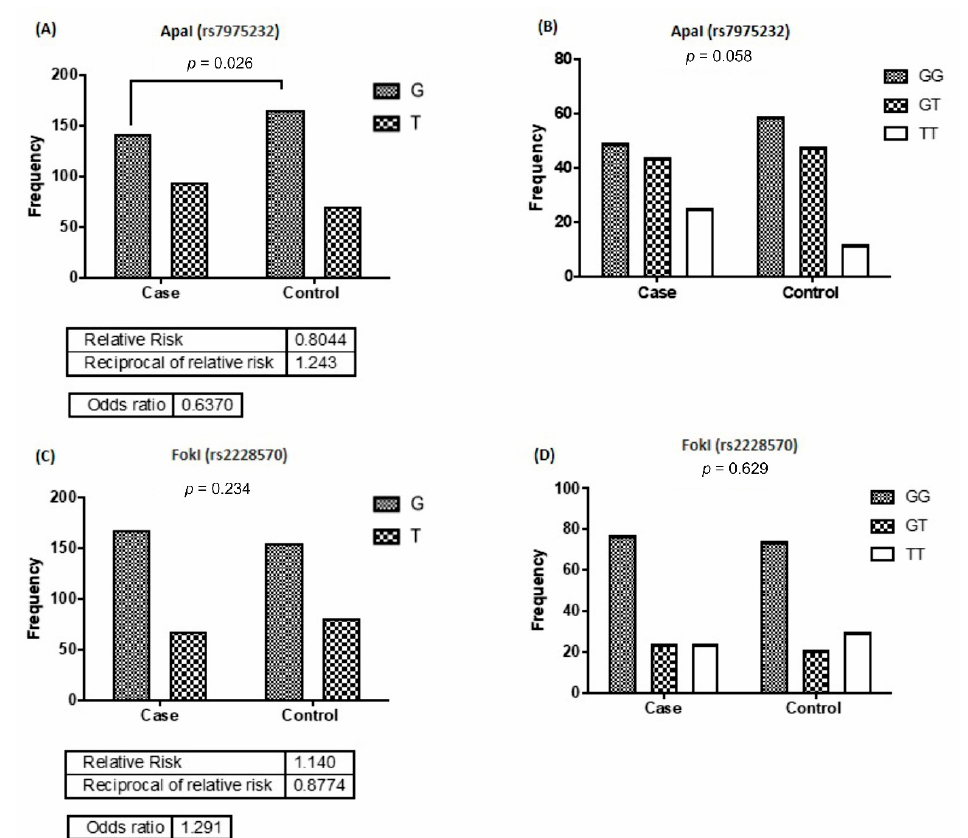
Figure 2. Allele and genotype frequencies of vitamin D receptor (VDR) polymorphisms in the studied groups. Comparing the ApaI ( A , B ) and Fok I ( C , D ) polymorphisms in kidney recipients and control groups.